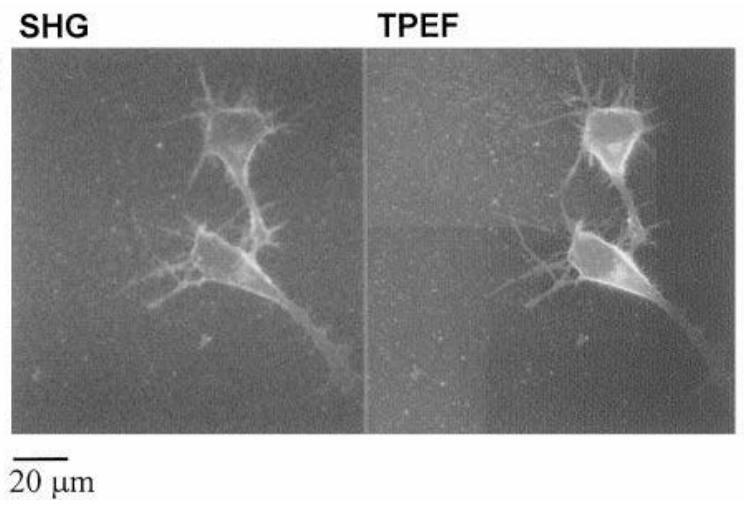
Figure 7. Second harmonic generation (SHG) and third harmonic generation (TPEF) images of Figure 7. second harmonic generation (SHG) and third harmonic generation (TPEF) images of di ff erentiated neuroblastoma cells (taken with the permission of differentiated neuroblastoma cells (taken with the permission of [31]).